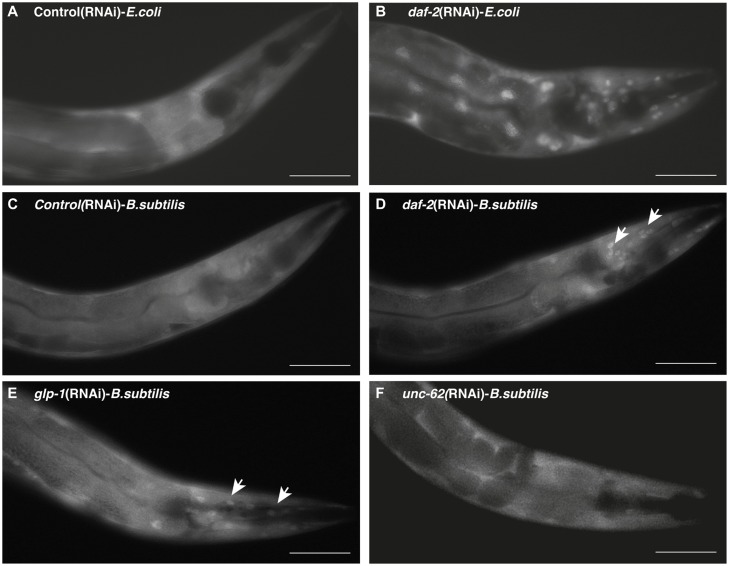
DAF-16/FOXO activated in daf-2 (RNAi) and glp-1(RNAi) mutants when grown on E. coli or B. subtilis.Green fluorescent protein images of adult TJ356 (Isdaf-16::GFP) transgenic animals shown at 40X. (A) Images of an animal raised on E. coli expressing empty vector for RNA interference. (B) Images of an animal grown on E. coli and exposed to E. coli expressing daf-2 dsRNA for 48 hours post development. Note strong nuclear localization in most tissues, including the intestine. (C) Image of an animal grown on B. subtilis expressing the empty vector for RNA interference. Images of animals fed B. subtilis expressing either (D) daf-2 dsRNA, (E) glp-1 dsRNA, or (F) unc-62 dsRNA for 48 hours post development. Note weak activation of DAF-16/FOXO in the head area upon treatment with daf-2 and glp-1 dsRNA. Scale bar = 100μm